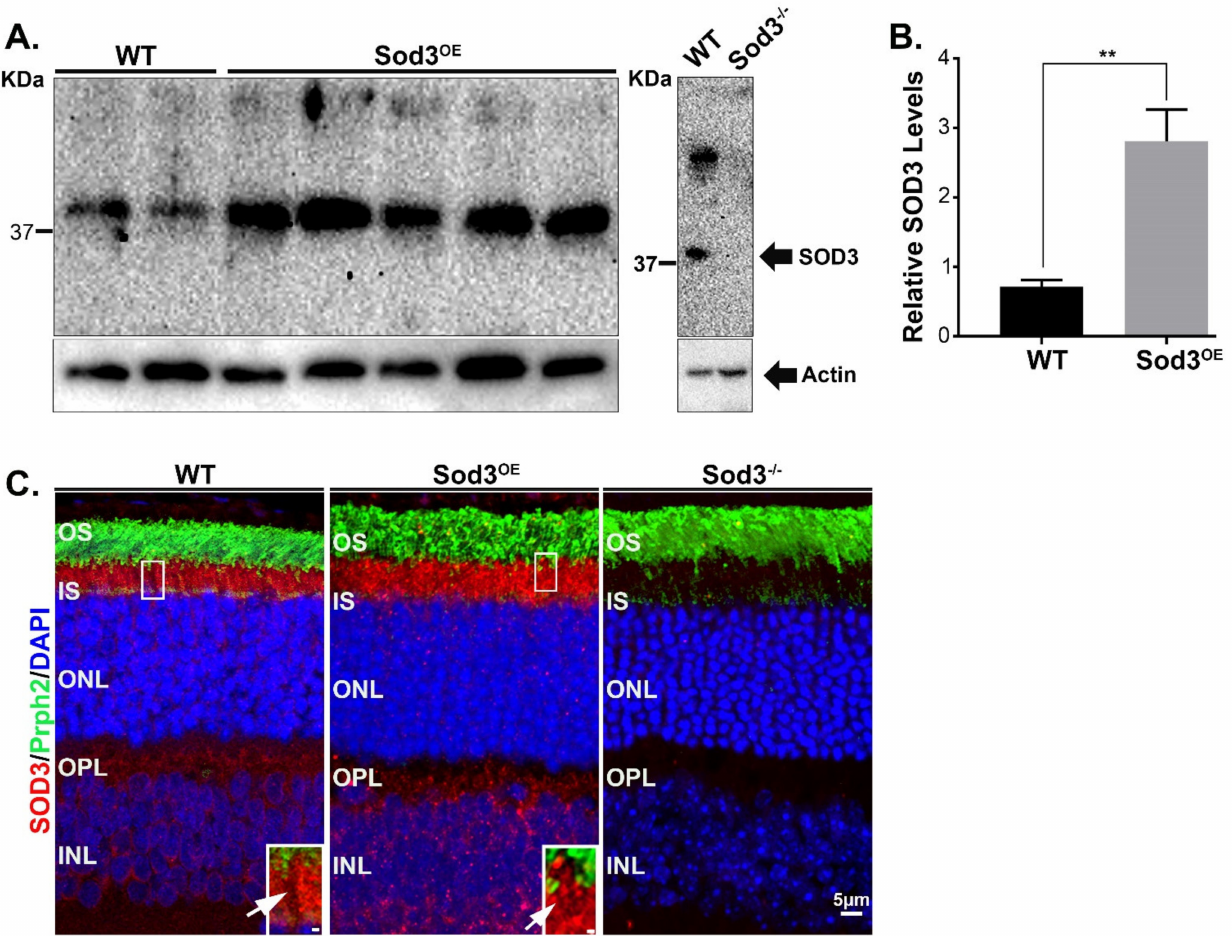
Figure 4. SOD3 levels and localization in Sod3 OE retinas. ( A ) Representative immunoblot of 1 month WT and Sod3 OE retinas demonstrate the overexpression of SOD3. Notice absence of SOD3 in Sod3 − / − retinas serving here as controls. ( B ) Quantification of SOD3 overexpression (plotted in arbitrary units relative to actin) from immunoblots using five independent retinas. Statistical significance was determined by Student’s t -test, where p = 0.0086. ( C ) Retinal sections captured at 40 × from 1 month old Sod3 OE , Sod3 − / − and WT immunolabeled with SOD3 and Prph2 antibodies. Image insets (regions marked by boxes) shows areas of low-fluorescence (white arrows) in the inner segment space. Scale bar is 5 µ m and 1 µ m in each inset. (** is p ≤